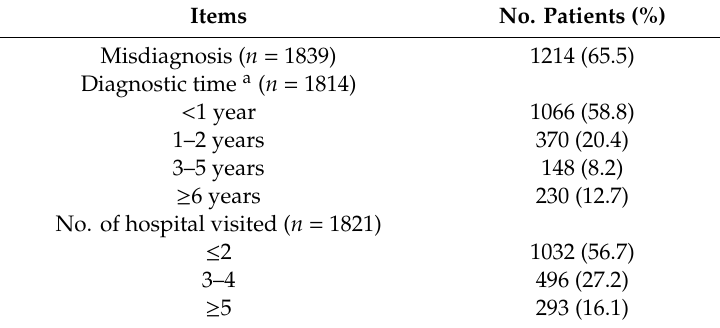
Table A2. Patients experience of diagnosis for rare disease.